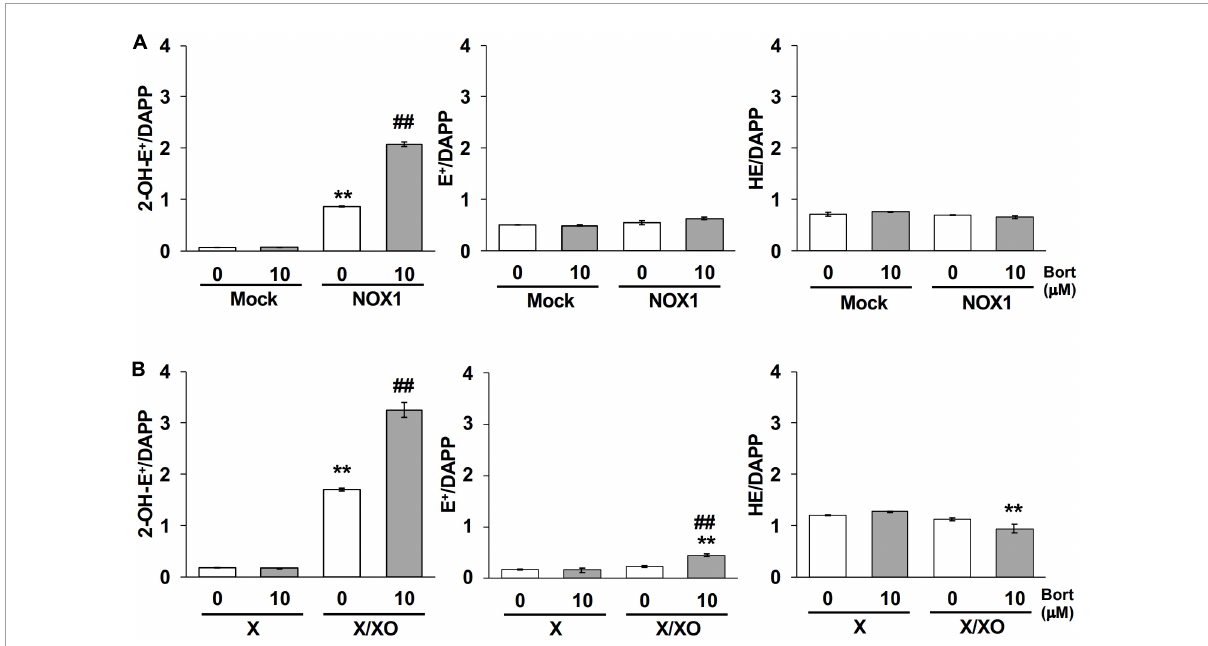
FIGURE5 Bortezomib increased the level of the superoxide-specific oxidative product 2-OH-E + . The levels of 2-OH-E + , E + , and HE in the supernatant of NOX1-expressing cells [ (A) , 2 × 10 6 cells/mL] and the X/XO system [ (B) , 0.2 mM X and 5 mU/ml XO] measured by LC-MS/MS. Data were expressed as a ratio to DAPP, an internal control. N = 3. Data were from two independent experiments, and expressed as the mean ± SEM. ∗∗ P < 0.01 versus the control (Mock or X). ## P < 0.01 versus 0 µ M.